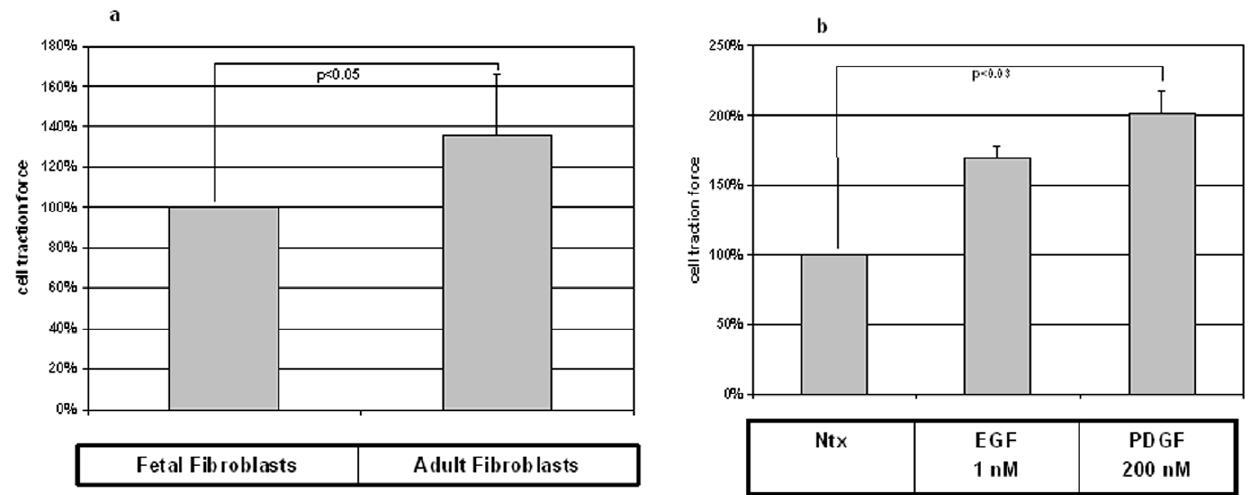
Figure 6. Adult fibroblasts are more contractile than fetal fibroblasts. (a) Fetal fibroblasts are less contractile than adult fibroblasts as determined by traction force microscopy. Each bar represents mean 6 SEM of more than 20 cells from two independent experiments. Statistical analyses were performed using Student’s t test. (b) PDGF treatment of adult fibroblasts results in an increase in the observed cumulative traction force; EGF treatment results in a similar although smaller increase. Each bar represents mean 6 SEM of more than 25 cells from two different